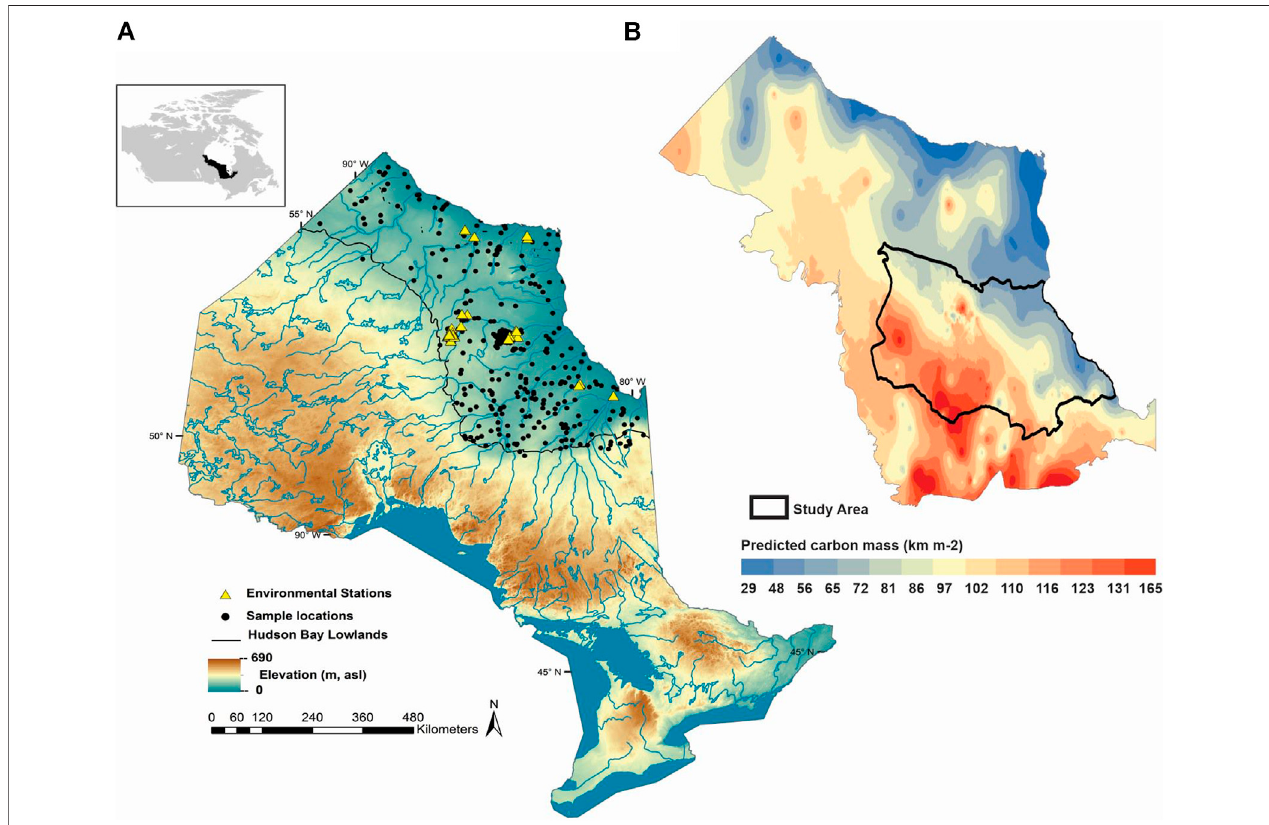
FIGURE 3 | Location of study site in northern Ontario, Canada, and maps of (A) elevation and peat sampling points and (B) predicted peat carbon mass for Ontario ’ s portion of the Hudson Bay Lowlands (location indicated in insert) and the study area (outlined in